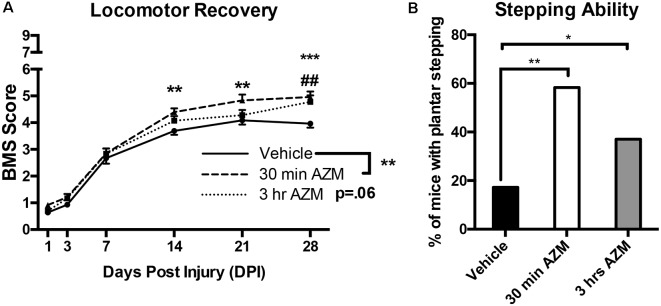
Early AZM administration improves locomotor recovery in SCI mice. Adult (4-month-old) female mice received a moderate-severe thoracic T9 contusion SCI (75-kdyn). AZM was first administered at 30-min or 3-h post-injury and then daily for 7 days (160 mg/kg/day). Functional recovery was assessed before injury and at 1, 3, 7, 14, 21, and 28 dpi. (A) Mice treated with AZM beginning 30-min post-injury displayed significantly improved locomotor recovery relative to vehicle (main effect of treatment vehicle vs. 30 min, p = 0.004) with significant improvement from 14 to 28 dpi (**,***p < 0.05 30 min vs. vehicle, Holms–Sidak’s post hoc). Mice first treated at 3 h post-injury had increased recovery relative to vehicle (p = 0.06 main effect of treatment vehicle vs. 3 h) with significant improvements at 28 dpi (##p < 0.05 vs. vehicle Holms–Sidak’s post hoc). (B) Mice treated at 30-min recovered significantly improved frequent plantar stepping frequency than vehicle controls (58% and 17% respectively, Chi-squared, p = 0.001). Similarly, mice treated at 3-h recovered significantly more frequent plantar stepping relative to vehicle (37% and 17%, respectively, Chi-squared, p = 0.04). n = 24–29, mean ± SEM. *p < 0.05.